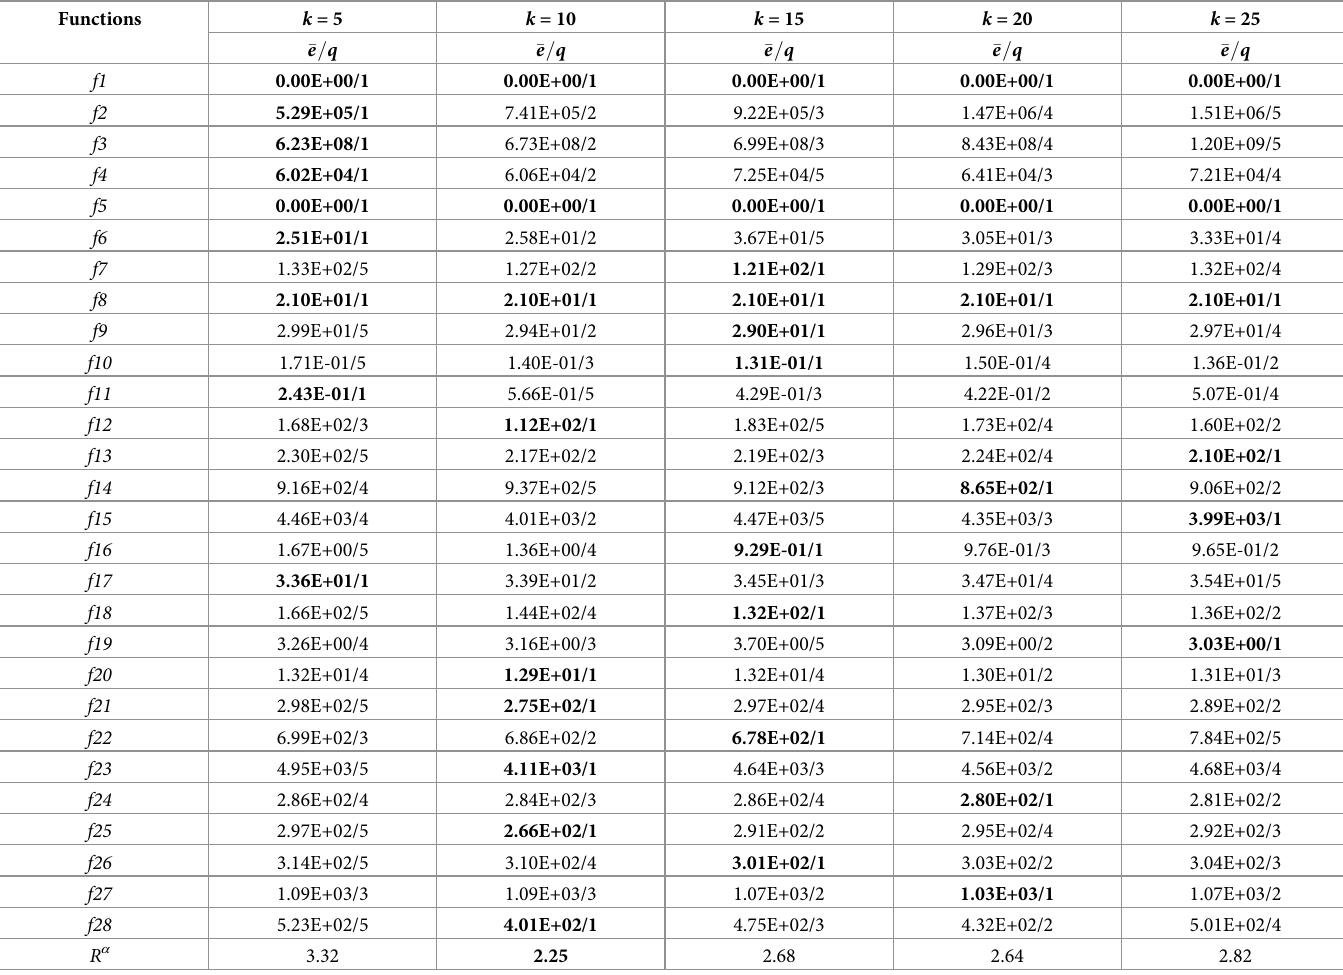
Table 2. Comparison of the results of different elite mayfly